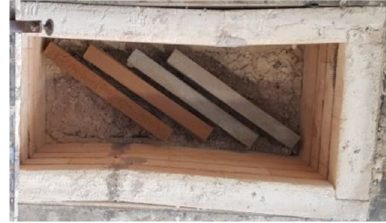
Figure 2. Flexure specimens in kiln after heating.